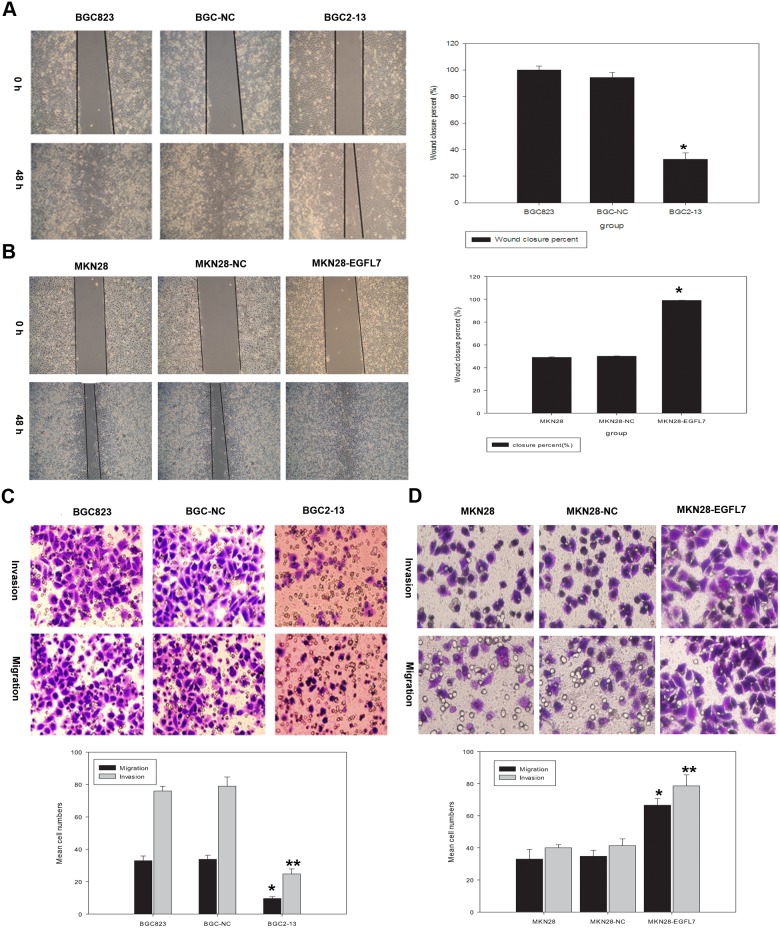
EGFL7 expression regulates GC cell migration and invasiveness.(A) Scratch wound healing was used to determine migration behavior in cell lines underexpressing or overexpressing EGFL7. A wound was generated and imaged at 0 and 48 h. Wound closure was significantly slower in (underexpressing) BGC2-13 cultures compared to BGC823 and BGC-NC cultures (32% vs. 100% and 98%, *P<0.05). (B) Wound closure was significantly faster in (overexpressing) MKN28-EGFL7 cultures compared to MKN28 and MKN28-NC cultures (99% vs. 49% and 50%, *P<0.05). (C) Invasive potential was assessed by the Matrigel invasion assay. Significantly fewer BGC2-13 cells passed through the Matrigel compared to BGC-NC and BGC823 cells (25±3.1 vs. 76±2.9 and 79±5.7, *P<0.05). For the transwell migration assay, cell lines were seeded in the upper chamber of the transwell. Significantly fewer BGC2-13 cells traveled through the transwell filter compared to BGC823 and BGC-NC cells (19±1.1 vs. 53±2.9 and 54±2.6, **P<0.05). (D) Significantly more MKN28-EGFL7 cells passed through the Matrigel to the lower side of the filter compared to MKN28-NC and MKN28 cells (79±6.19 vs. 40±2.00 and 41±4.22, *P<0.05). Similarly, significantly more MKN28-EGFL7 cells that traveled through the transwell filter compared to MKN28 and MKN28-NC cells (67±4.16 vs. 33±5.92 and 35±3.7, **P<0.05).